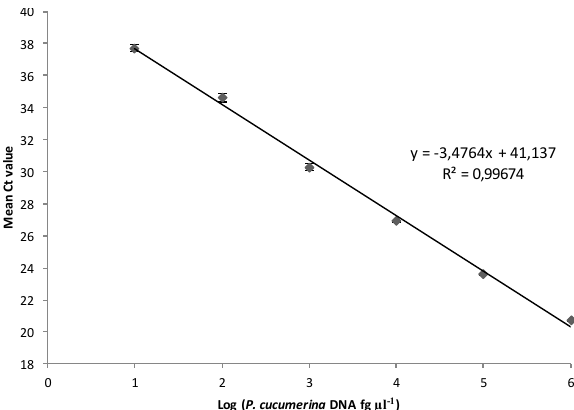
Figure 1. Standard curve and correlation coefficient as - sessed with a dilution series of Plectosphaerella cucumer- ina DNA for the Pa. cucumerina F2/R2/P1 real-time PCR assay. DNA of the pathogen was obtained from healthy rocket leaves (concentration 50 ng μL -1 ). Mean Ct values are for duplicate reactions; error bars indicate standard de-